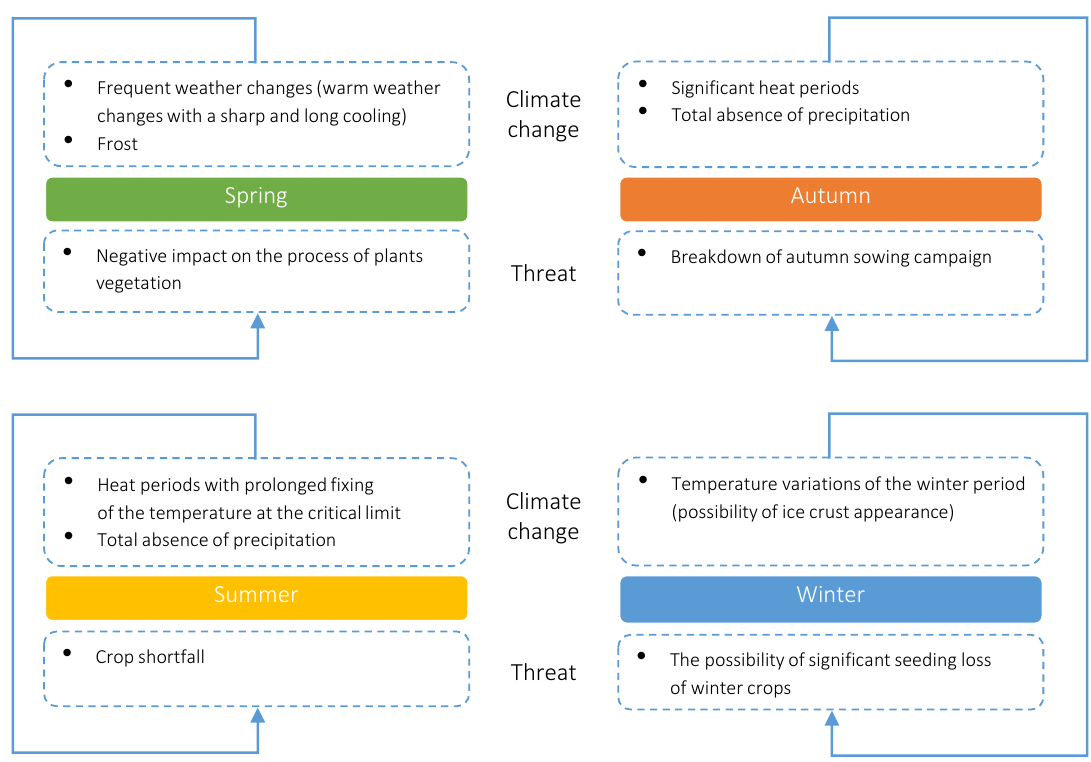
Figure 1. Threats to the agrarian sector of the Ukrainian economy caused by climate